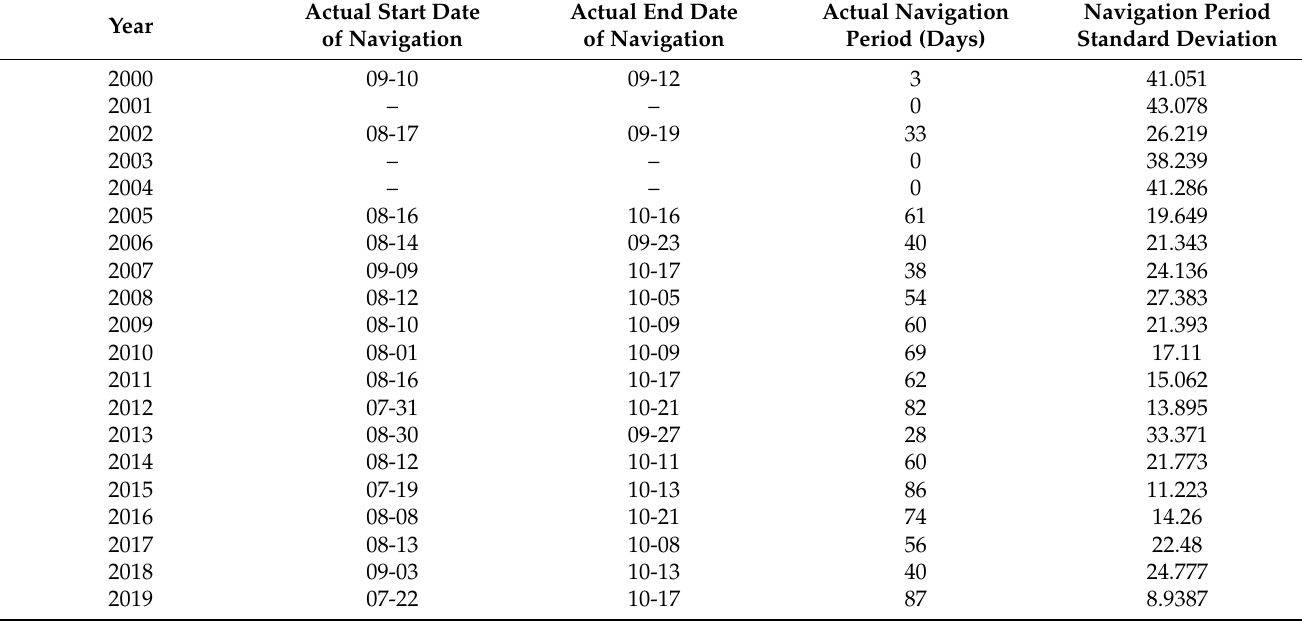
Table 1. Navigation schedule of the NEP from 2000 to